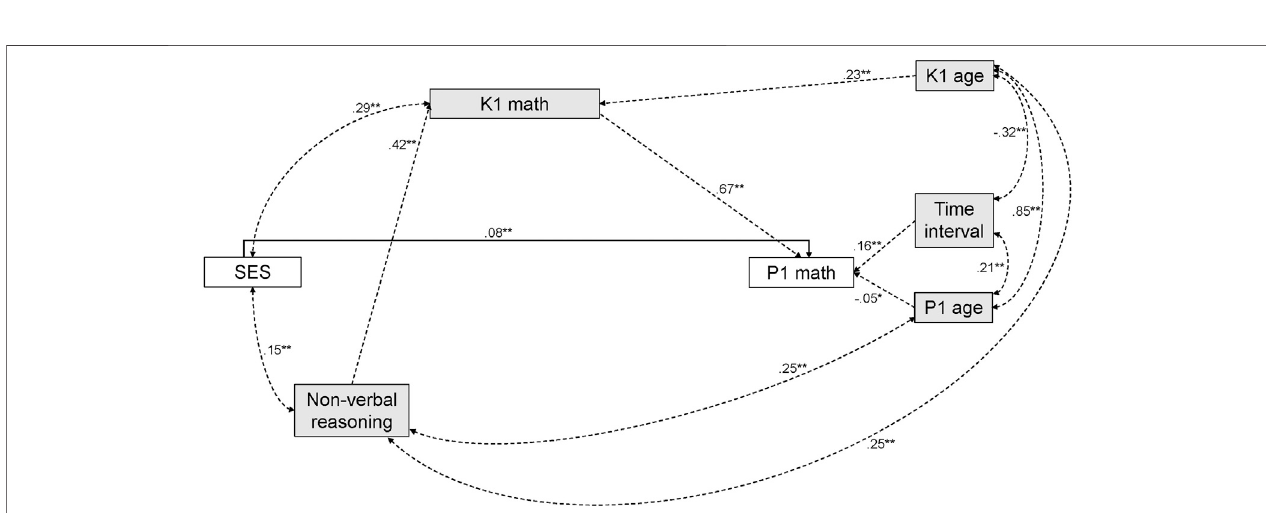
FIGURE2| Model1examinedthein fl uenceofsocio-economicstatus(SES)onmathachievementatPrimary1(P1math),controllingforchild ’ sageatKindergarten 1 (K1) and P1, time interval between K1 and P1assessmentof math skills, math skillsat K1, and non-verbal reasoning. Dashed paths re fl ect predictive and correlational paths involving control variables. All path coef fi cients are standardized estimates. R 2 P1 math (cid:1) 0.48, p < 0.01, * p < 0.05, ** p < 0.01.